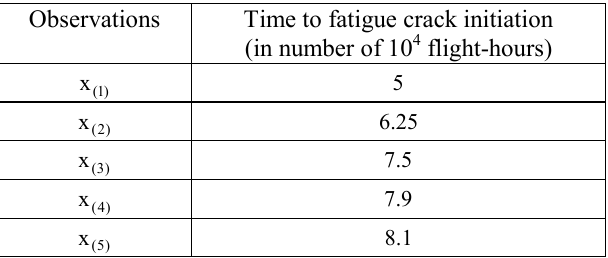
Table 1. The data of fatigue tests on a particular type of structural components of IL-86aircraft